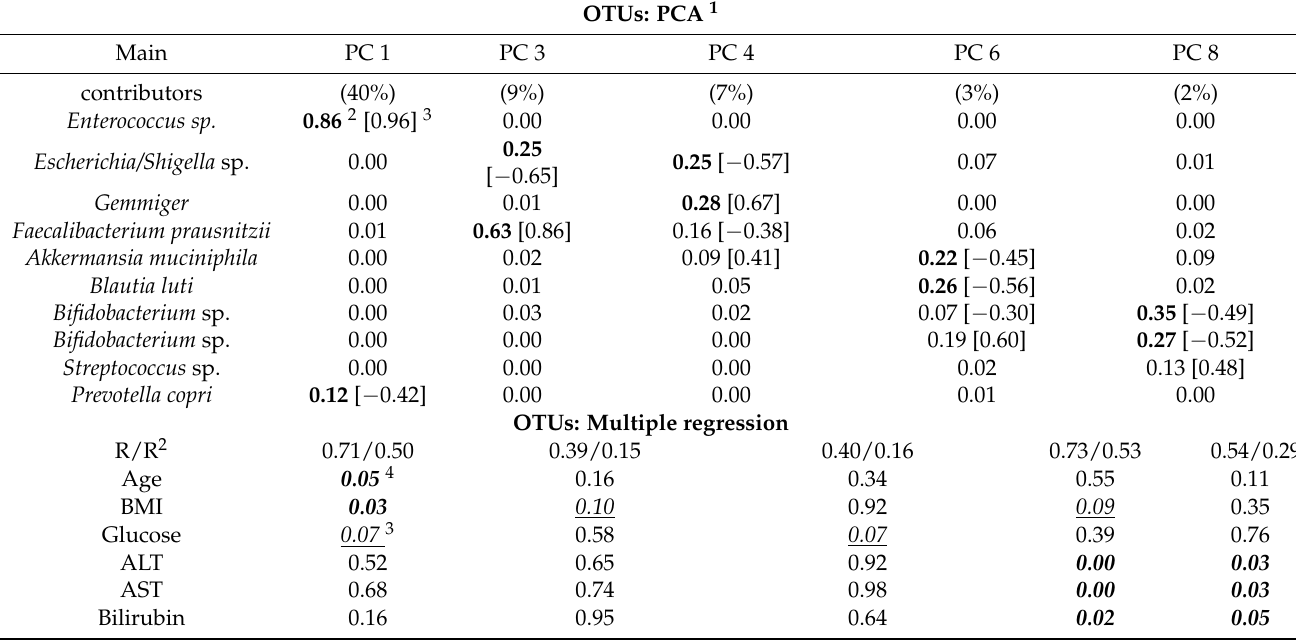
Table 4. Statistical analyses’ results: contribution of bacterial OTUs into the principal components extracted from the matrix with relative abundance in feces of females with gallstone disease before CCE (percentage of total variance in brackets) and p -values for multiple regression with age, BMI and blood biochemistry (coefficients of determination in